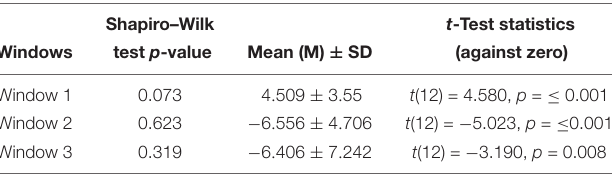
TABLE 2 | Shapiro–Wilk test p- value, mean, standard deviation, t -test statistics (two-tailed) result of the difference in difference ERP’s peak amplitudes against zero in the three time-windows.